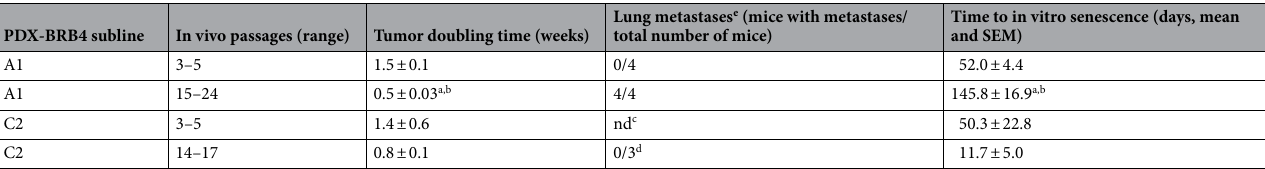
Table 2. Functional progression of PDX-BRB4-A1 subline. a P < 0.05 at least vs A1 3–5 passages (Student’s